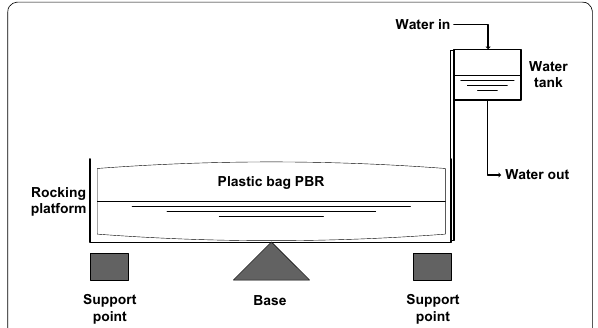
Fig. 1 Plastic bag horizontal photobioreactor in rocking platform driven by water